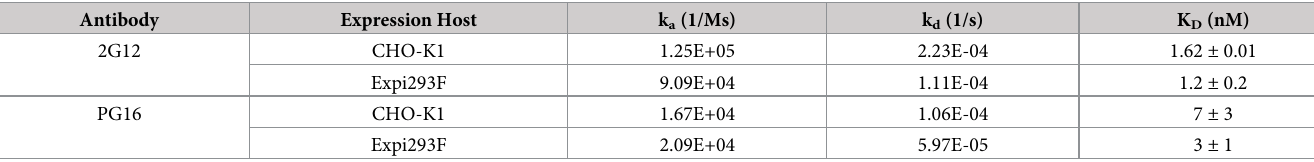
Binding kinetics were obtained using the Octet QKe system. Broadly neutralizing antibodies were captured on an anti-human IgG Fc sensor and dipped into different dilutions of gp145. Association/dissociation rates were analyzed using the ForteBio analysis software. Values represent mean ± standard deviation (STD) from three independent